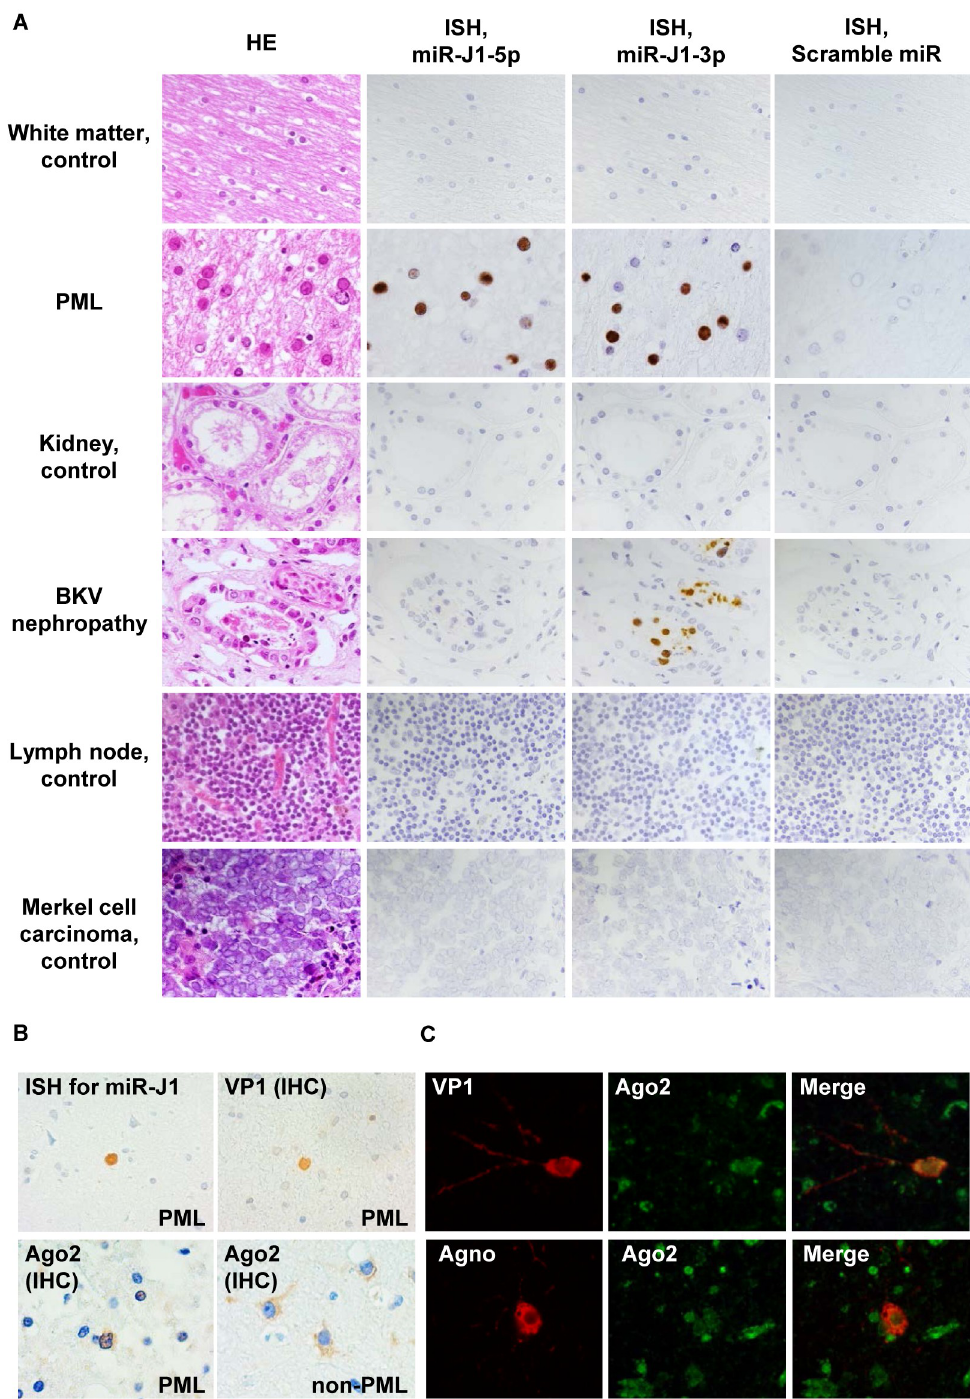
Fig 2. Specificity of in situ hybridization (ISH) for miR-J1 and Ago2 expression in clinical samples. (A) ISH for miR-J1 in clinical samples. HE and ISH for miR-J1-5p, miR-J1-3p, and a scramble probe are shown. All control samples were obtained from patients with conditions unrelated to PML or BKPyV-associated nephropathy. (B) miR-J1, JCPyV-VP1, and Ago2 protein expression in a case of PML. In situ hybridization detected miR-J1 in the PML case (upper left). JCPyV VP1 (upper right) and Ago2 (lower panels) were detected with immunohistochemistry in a PML lesion (upper right and lower left) and non-PML lesion (lower right). (C) Immunofluorescence assay for JCPyV VP1, agnoprotein, and Ago2 in a case of PML. JCPyV proteins (VP1 and agnoprotein) and Ago2 were labelled with red and green, respectively.